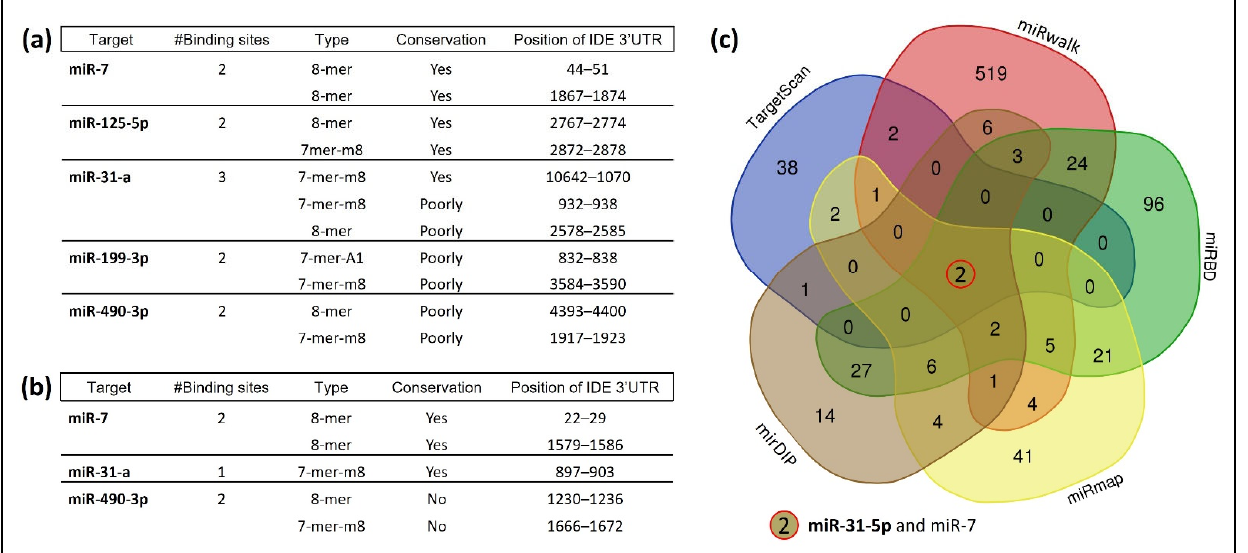
Figure 1. Prediction analysis of IDE target by multiple miRNAs. ( a ) Predicted human target miR ‐ NAs of IDE, showing the number and type of binding sites and their conservation. ( b ) Predicted mouse target miRNAs of IDE, showing the number and type of binding sites and their conservation. ( c ) Venn diagram depicting hIDE targeting miRNAs predicted by five different bioinformatic data ‐ bases.